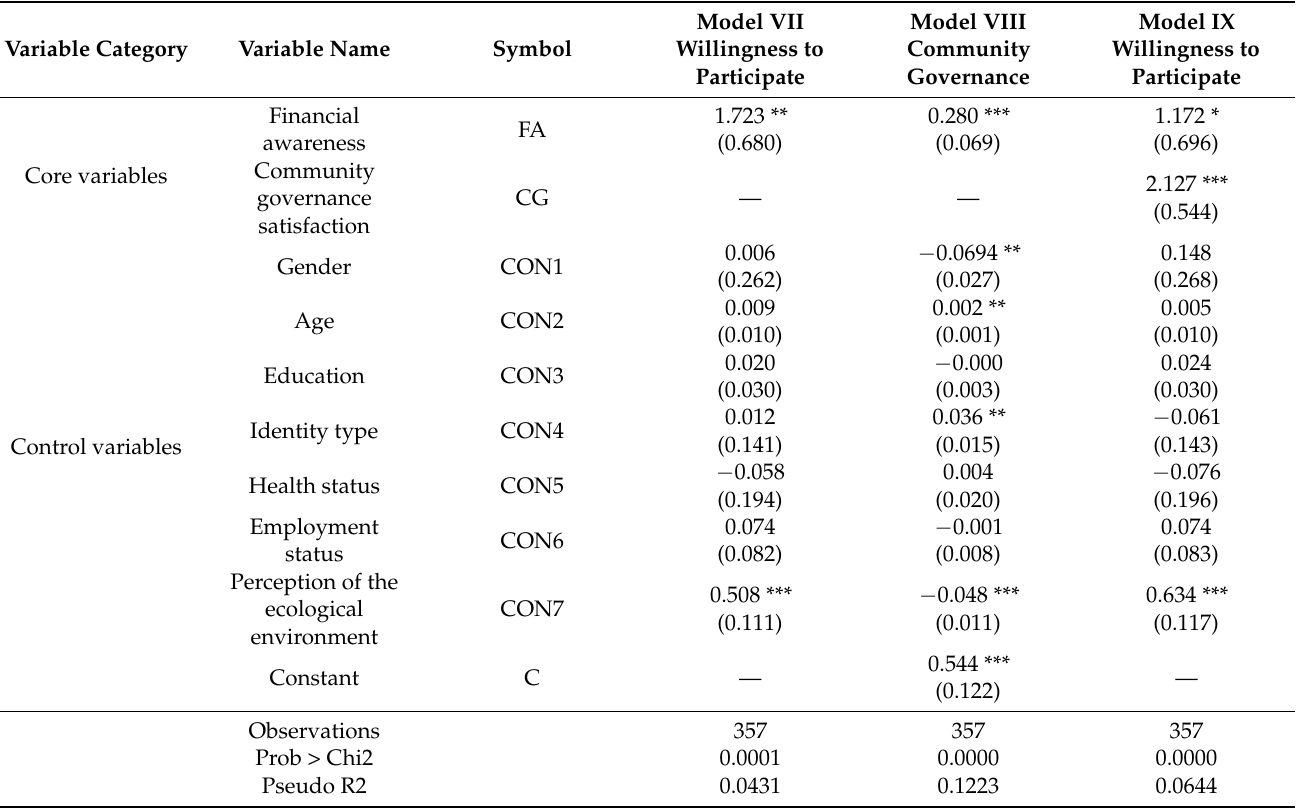
Table 7. Robustness test